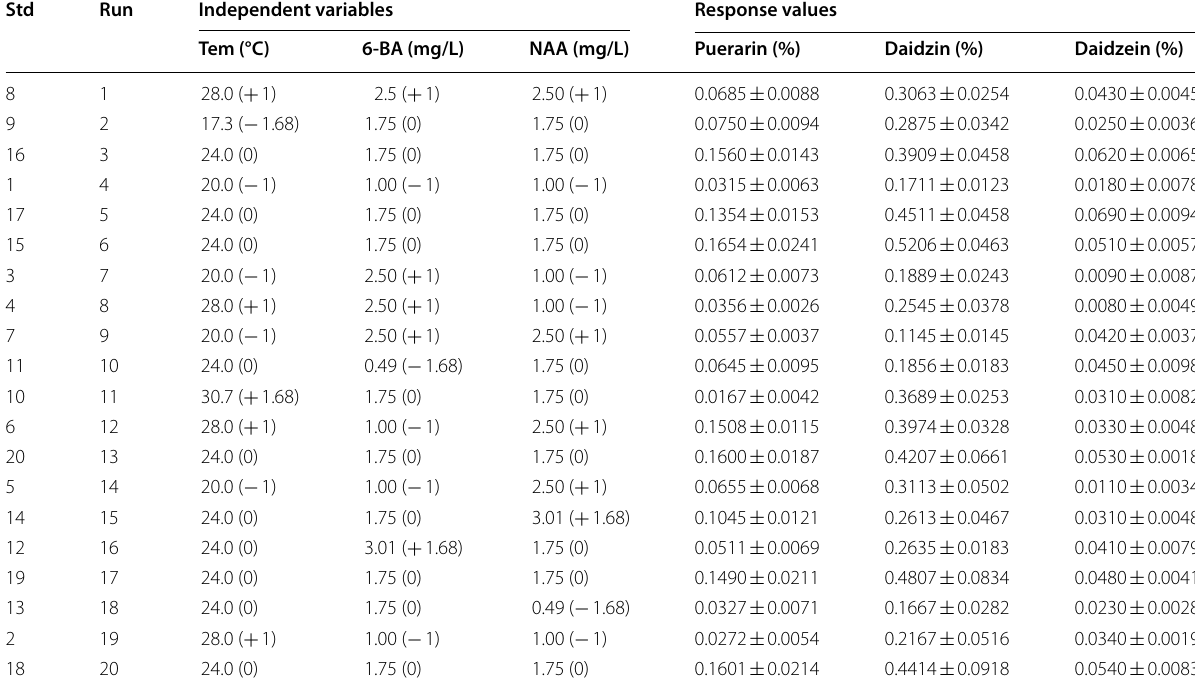
Data are expressed as means